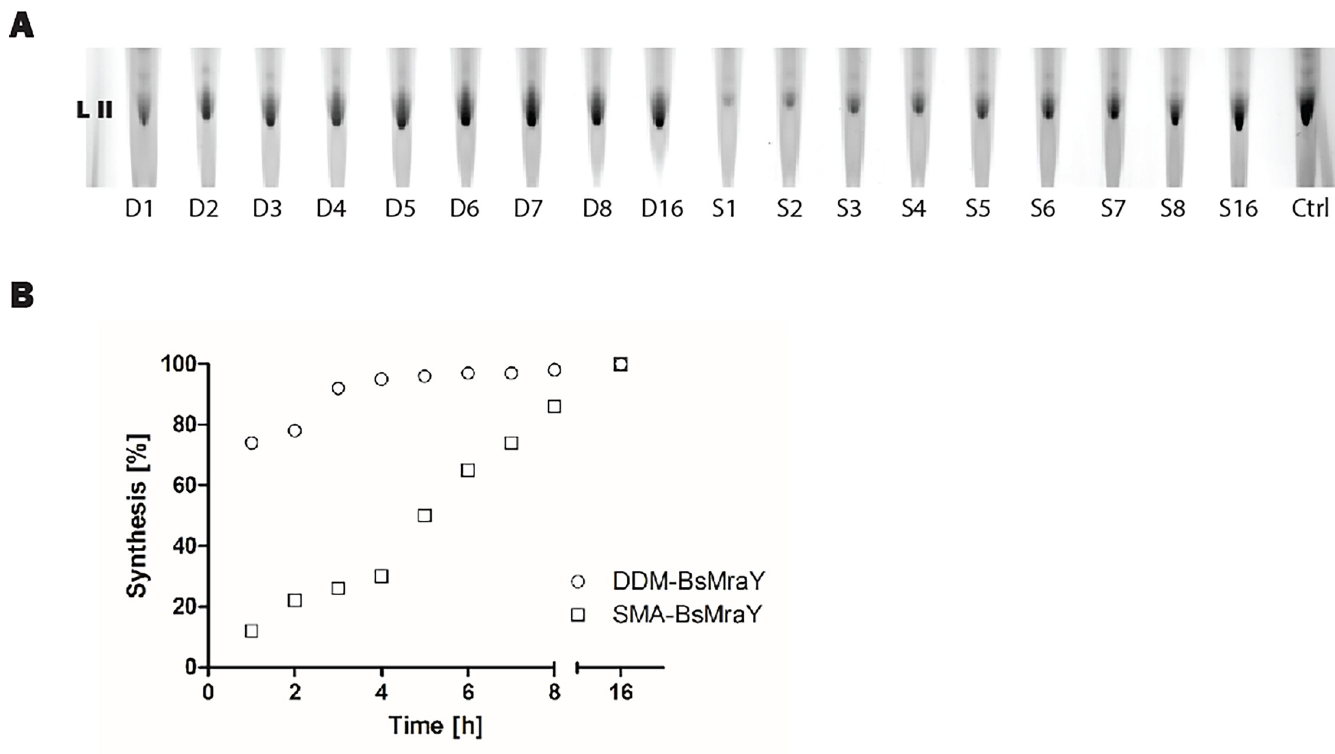
Fig 4. Kinetic analysis of Lipid II synthesis with MraY. (A) TLC analysis of Lipid II synthesis with either DDM-MraY (D1-16) or SMA-MraY (S1-16). The first spot from the bottom of the plate represents Lipid II (indicated as LII in the figure). (B) The intensity of Lipid II spots was analyzed by Image J and plotted against the incubation time. Reaction of 16 hours resulted in the most intensive Lipid II spot on the TLC plate for both enzyme preparations and were assigned as 100% activity recovery.